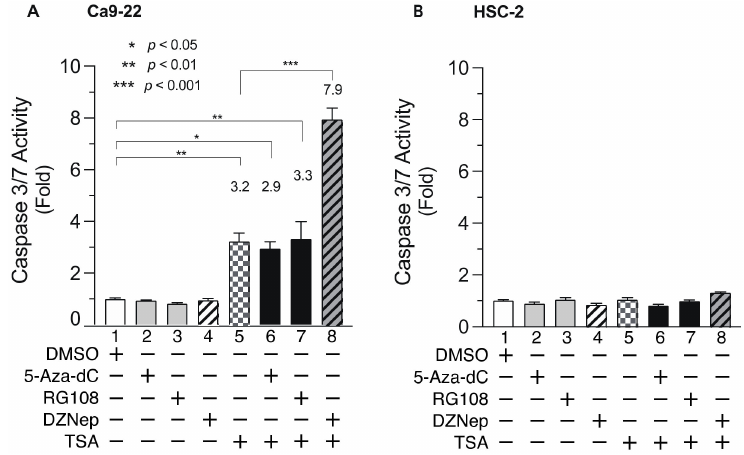
Figure 6. Caspase 3/7 activity in Ca9-22 and HSC-2 cells treated with DNMTis, HMTis, and HDACis. Caspase 3/7 activity levels in Ca9-22 ( A ) or HSC-2 ( B ) cells following treatment with 5-Aza-dC (0.1 µ M), RG108 (5 µ M), DZNep (0.2 µ M), or TSA (0.05 µ M) alone or in combination for 24 h. Caspase activity is expressed relative to activity in DMSO-treated cells. Data are presented as the mean ± SEM of three independent experiments. Significant differences were assessed by one-way ANOVA. (*